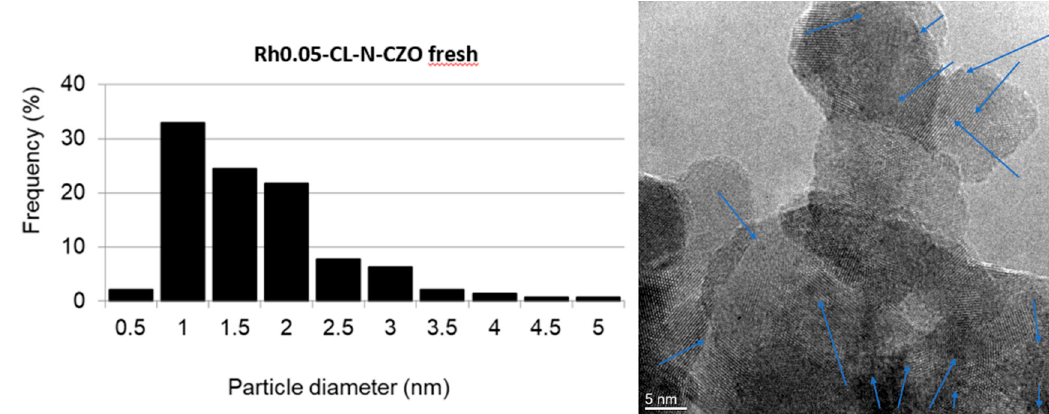
Figure 13. Rh particle-size distribution of the Rh cluster deposited on CZOm support determined by Transmission Electron Microscopy (TEM) analysis.